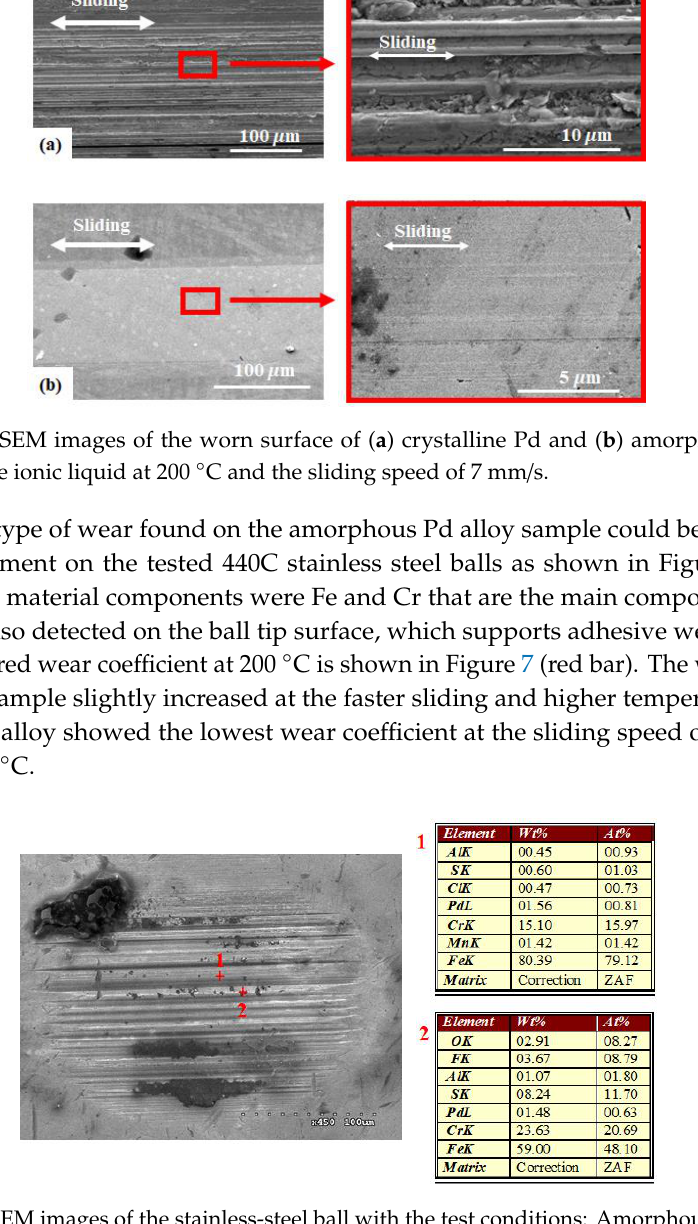
Figure 11. The morphologies of the worn surfaces: ( a ) 3D topography and ( b ) SEM image of crystalline Pd with sliding speed of 3 mm/s and ( c ) 3D topography and ( d ) SEM image of amorphous Pd alloy with sliding speed of 3 mm/s under the IL lubrication at 200 °C.